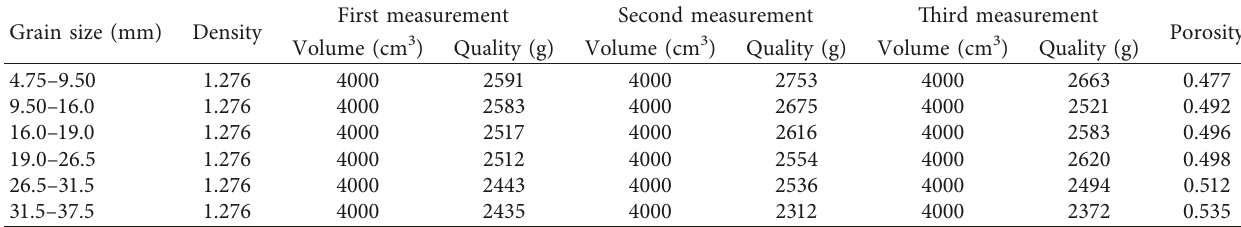
Table 1: The porosity of crushed coal with different grain sizes.